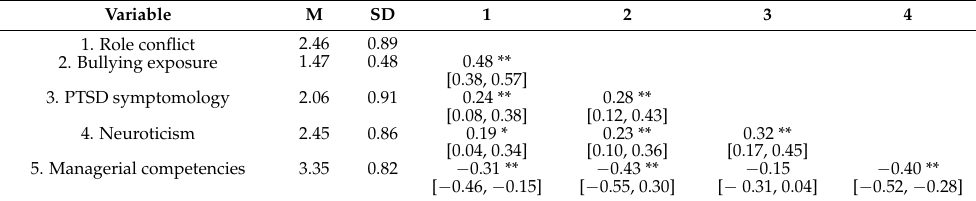
Table 1. Means, standard deviations, and correlations with confidence